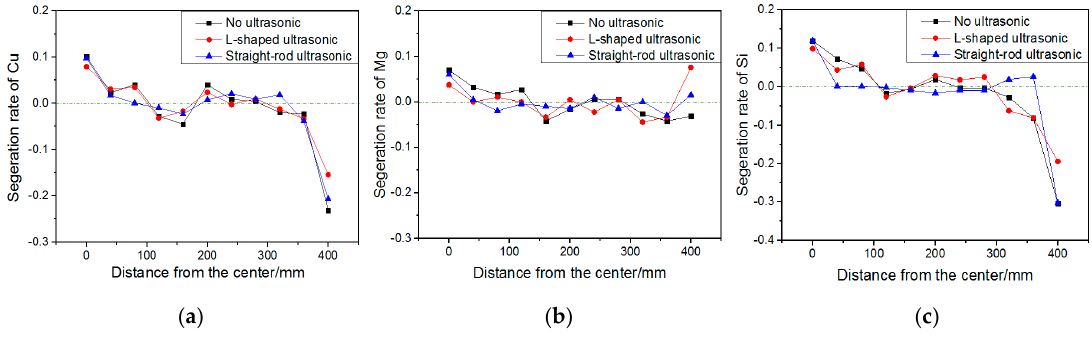
Figure 11. Variation of segregation rate of Cu ( a ), Mg ( b ), and Si ( c ) elements in the cross section of ingots under different processing conditions.